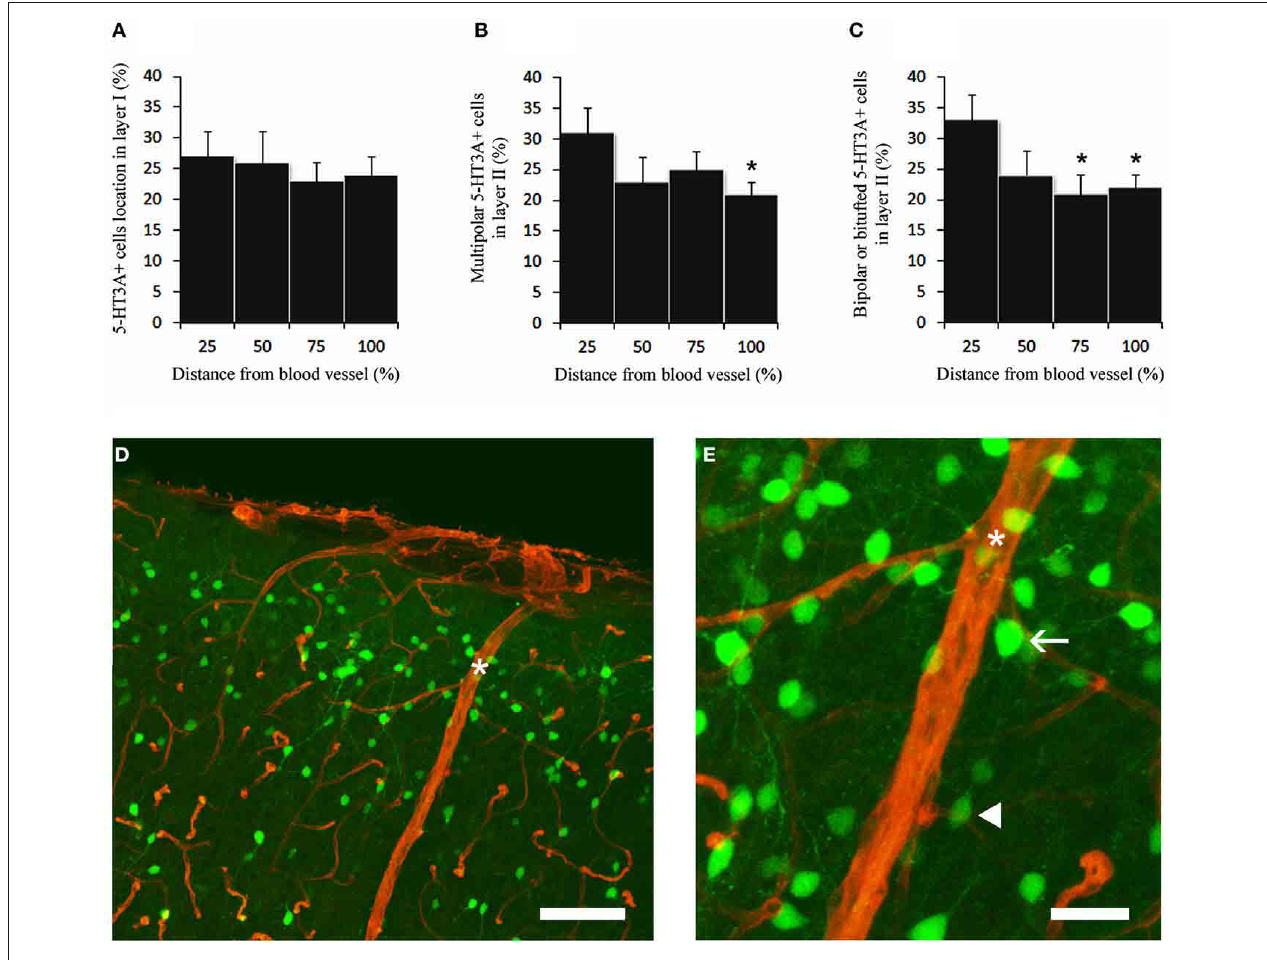
FIGURE 3 | 5-HT 3A :GFP + neurons in relation with the closest large penetrating blood vessel. (A) In layer I, 5-HT 3A :GFP + neurons do not show specific preferences to be located close to large penetrating blood vessels. (B,C) By contrast in layer II multipolar and bipolar/bitufted 5-HT 3A :GFP + neurons are preferentially positioned in the vicinity of penetrating blood vessels. (D) Confocal picture of a coronal section taken at the level of the supragranular layers of the somatosensory